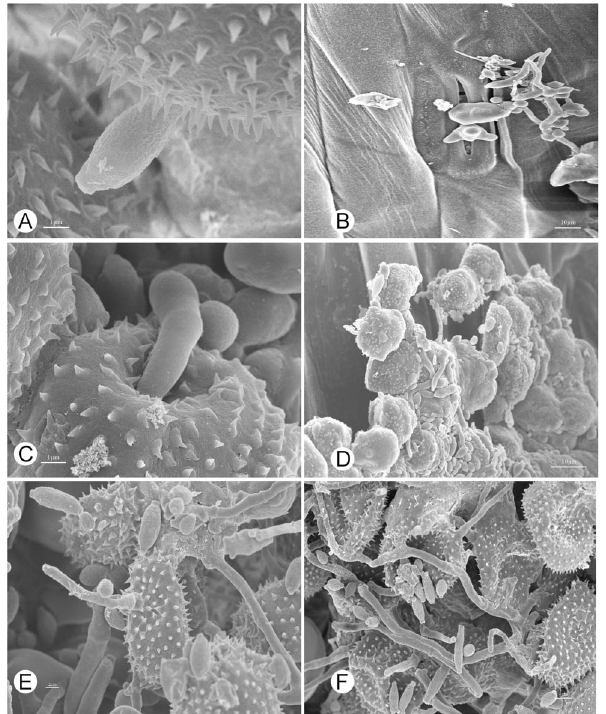
Figure 5. SEM observations of Pst inoculated with C . cladospor- ioides . A : 12 h after inoculation, the spore of C . cladosporioides contacted the urediniospore surface ( 6 7,000), B : 24 h after inoculation, spores of C . cladosporioides germinated ( 6 700), C : 36 h after inoculation, direct penetration by germ tube of C . cladosporioides into a urediniospore ( 6 10,000), D : 48 h after inoculation, amount of urediniospores were surrounded with germinated spores of C . cladosporioides ( 6 2,000), E : 72 h after inoculation, germ tubes of C . cladosporioides have penetrated urediniospores ( 6 3,000), F : 120 h after inoculation, C . cladosporioides has colonized the urediniospores ( 6 1,300).